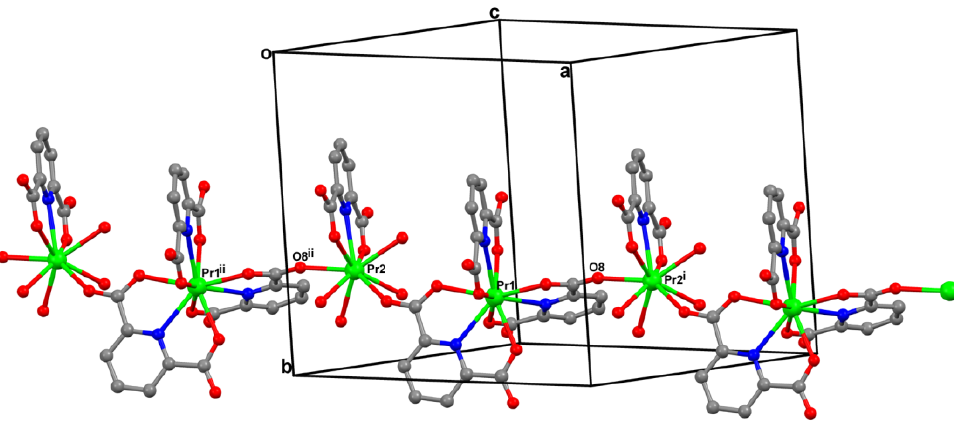
Figure 4. Fragment of a [100] chain of alternating Pr1- and Pr2-centred polyhedra in 1 .